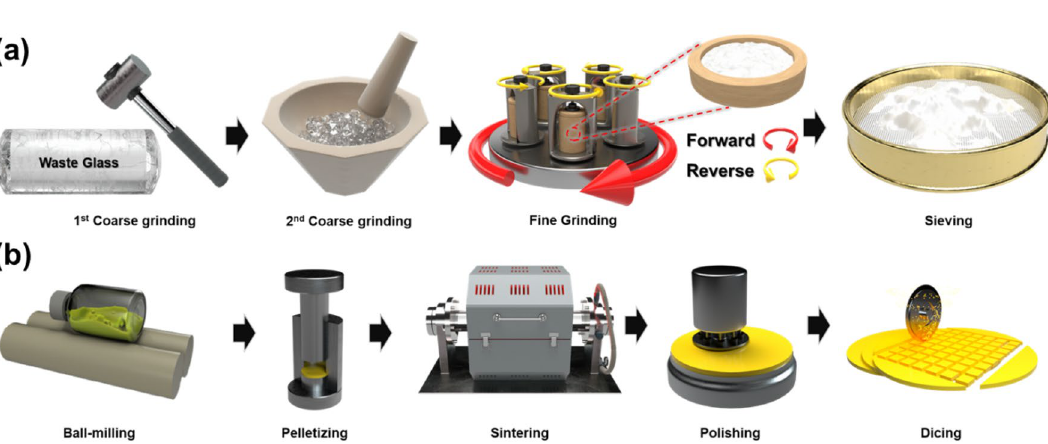
Figure 1. ( a ) Pulverizing process of cylindrical waste glass. ( b ) Fabrication process of